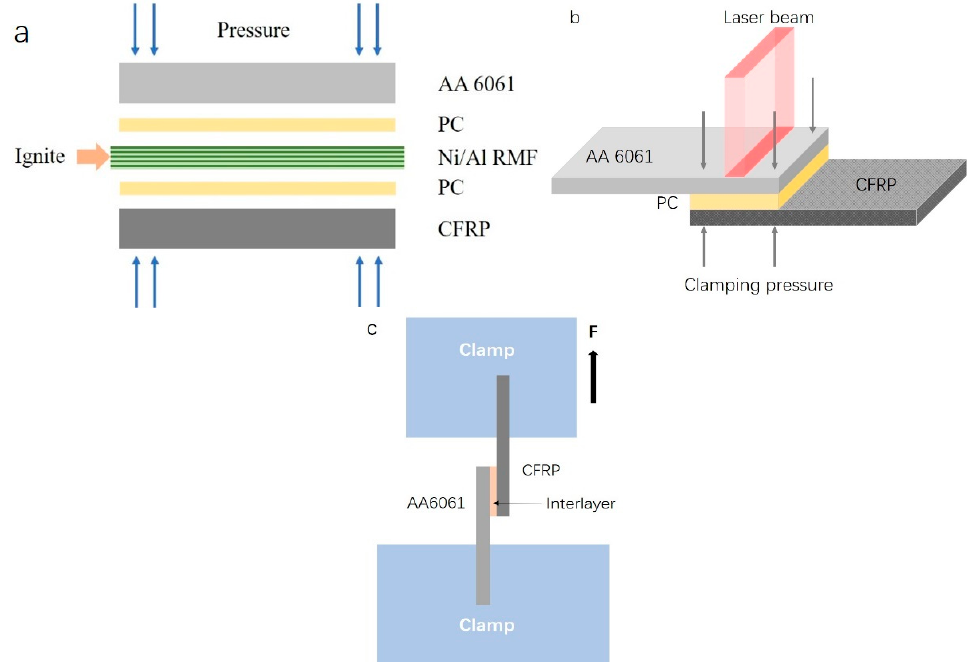
Figure 1. Schematic image of ( a ) the self-propagating joining using Ni/Al multilayer film; ( b ) the laser joining; ( c ) the lap tensile testing.